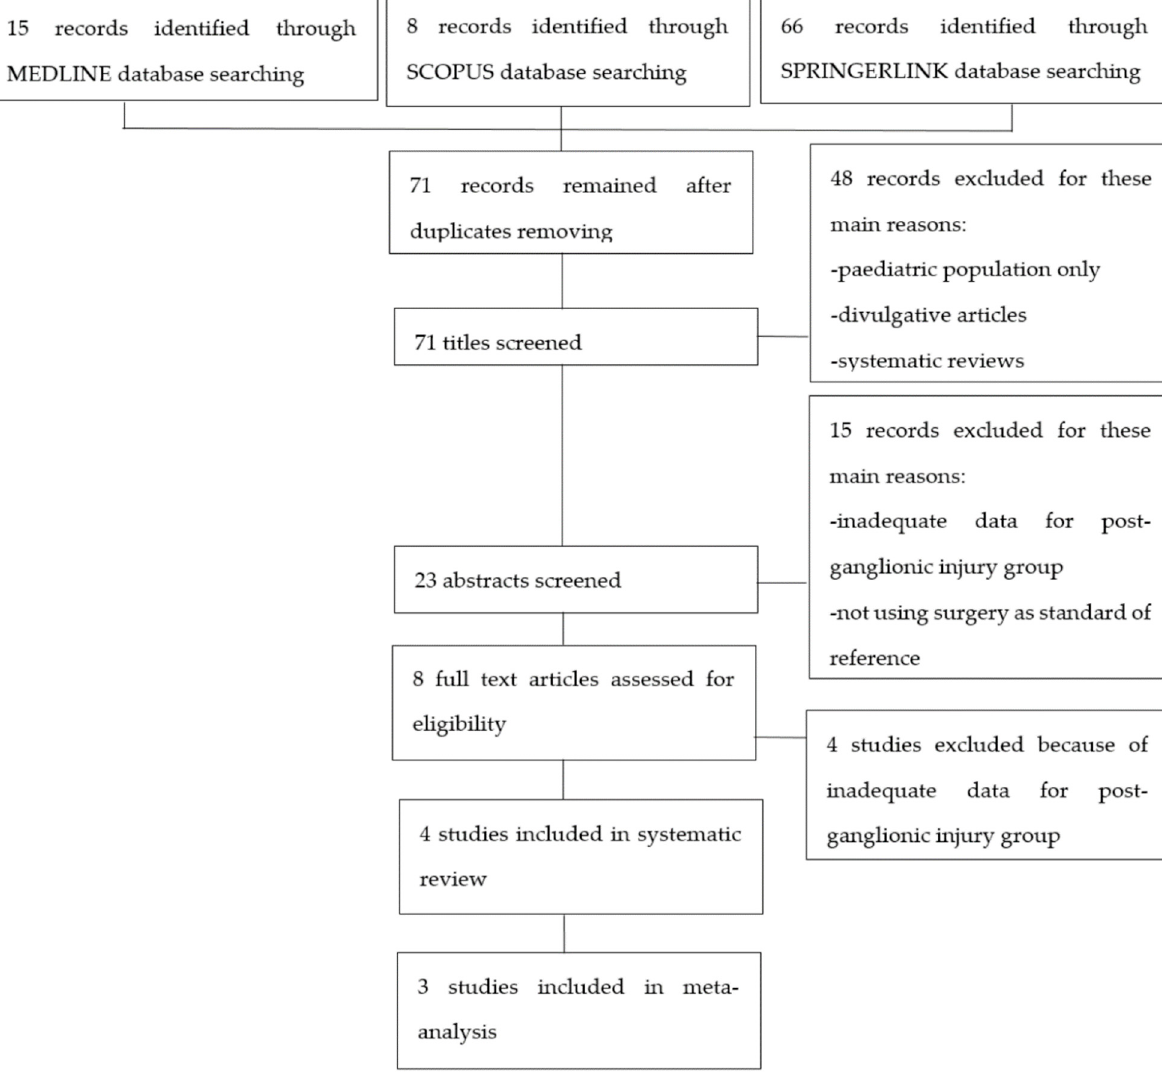
Figure 1. Flowchart of study selection process.